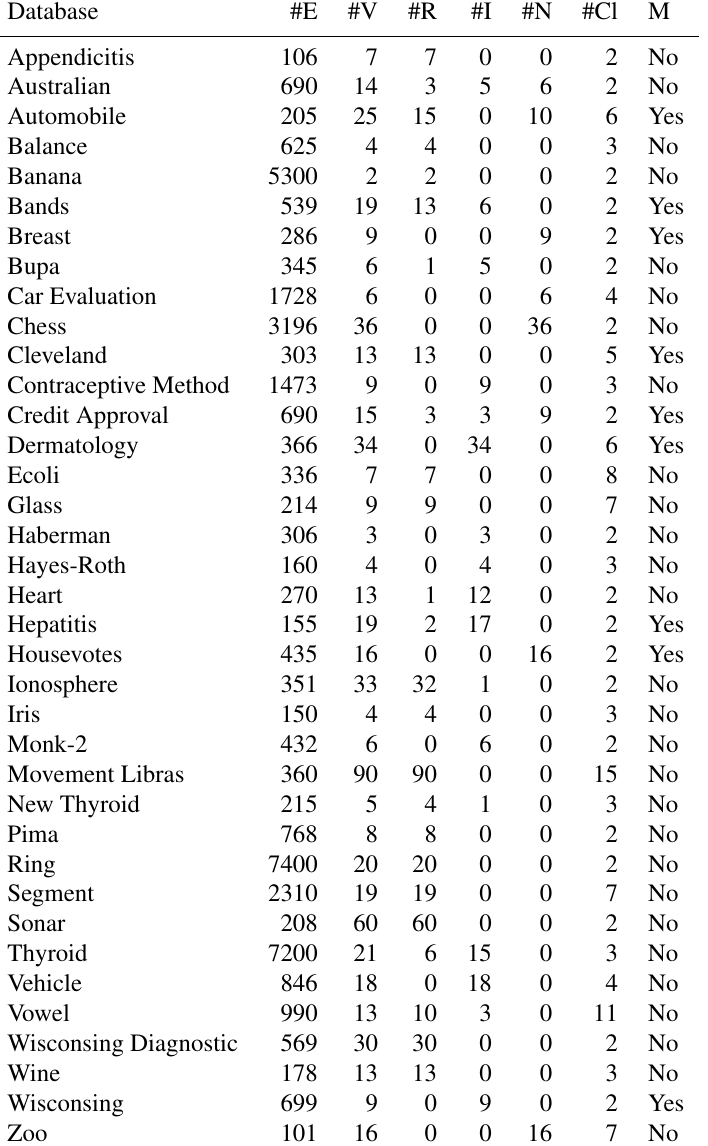
Table 1. Database used for the experimental study.